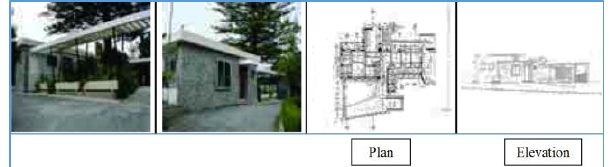
Figure 18. Somek house exposed stone facades, Plan and Façade. (Celik, 2005)